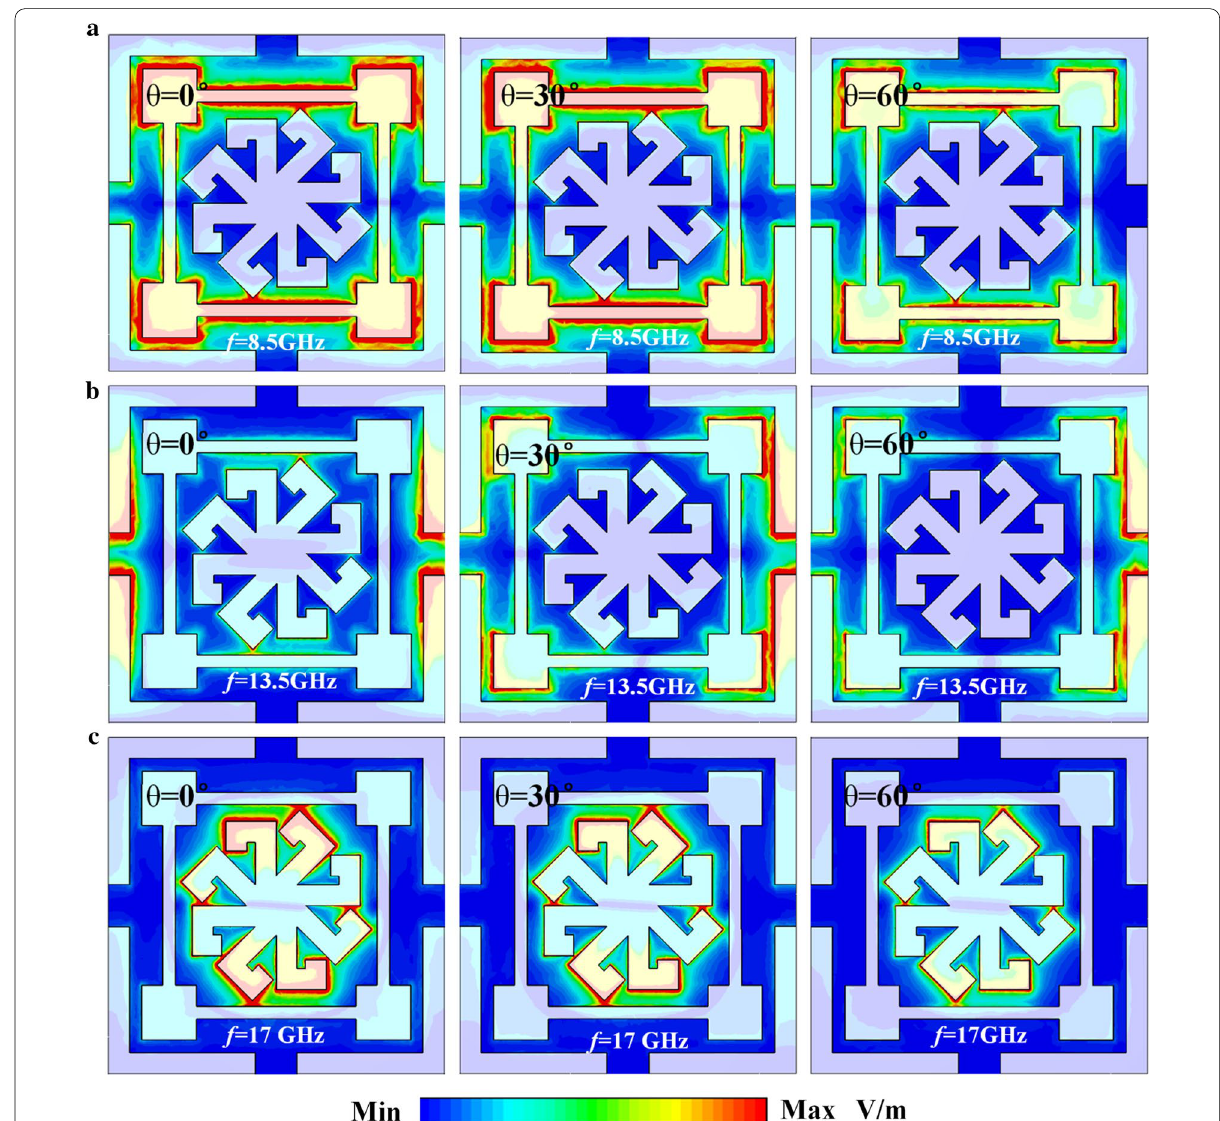
Fig. 5 The absolute of electric field distribution (| E |) in the MA for TE polarization at different incident angle θ of a 8.5, b 13.5, and c 17